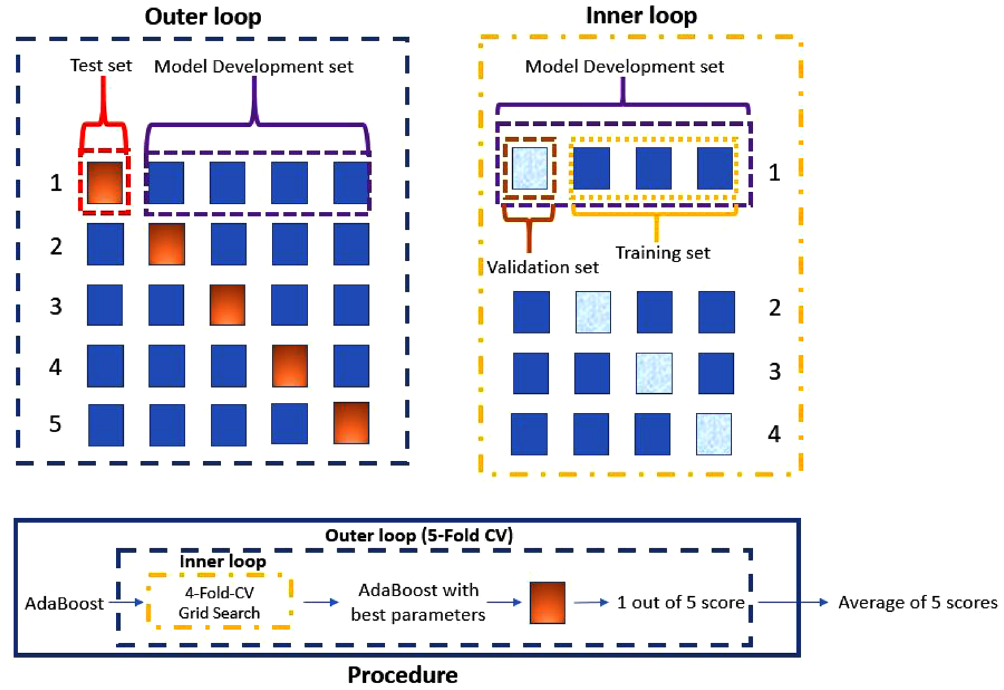
Figure 1. Schematic representation of the Nested-5-Fold-Cross-Validation procedure used in this